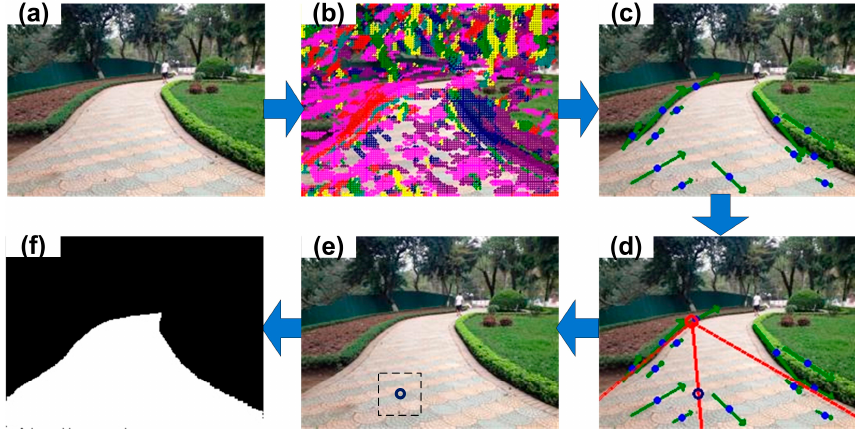
Figure 1. Pipeline of the traversable region detection: ( a ) input image, ( b ) estimating texture orientations (represented by different colors) using Gabor filters, ( c ) grouping dominant pixels with the same orientation into line segment candidates (in green with a blue point), ( d ) estimating the vanishing point (red circle) by the voting of line segment candidates and locating the seed pixel (blue circle), ( e ) selecting a sample region surrounding the seed pixel and constructing an appearance model, ( f ) classifying the pixels into traversable/non-traversable area.